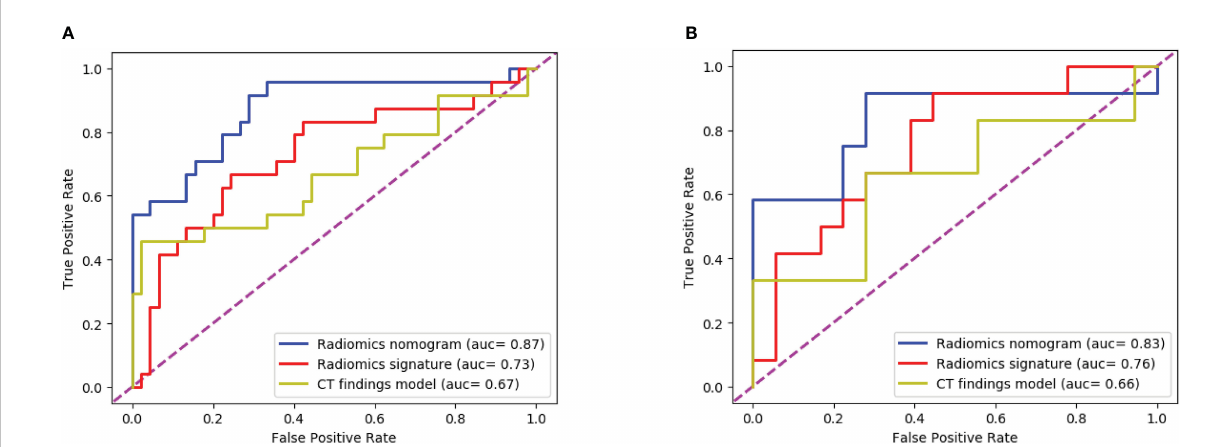
FIGURE 8 The ROC curves of the three models: (A) The training cohort; (B) The test cohort. The AUC values of the radiomics nomogram model were higher than that of the CT appearance model and the radiomics model in both training cohort and test